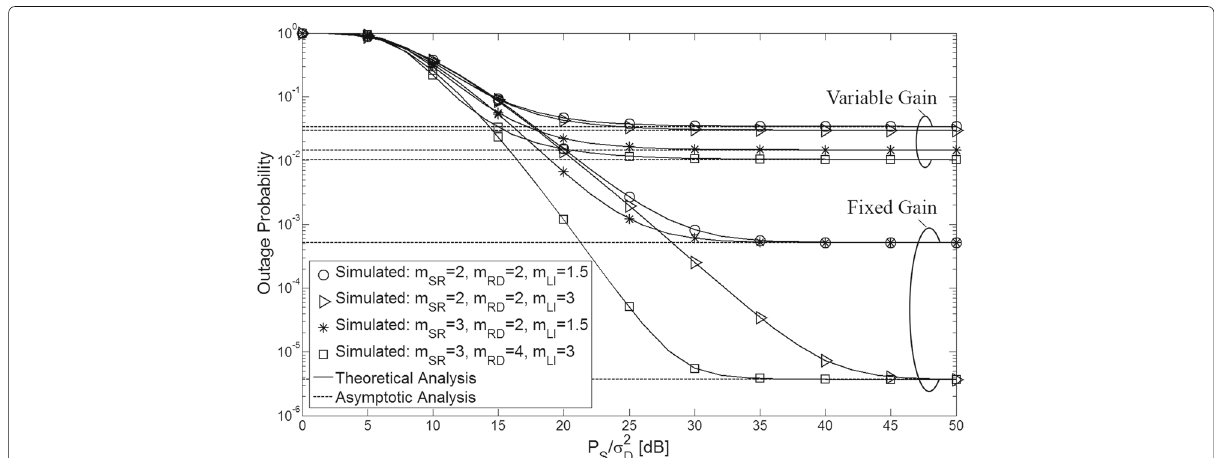
Fig. 4 Outage probability of the fixed-gain and variable-gain AF-FD systems for (cid:6) LI = 0.06, γ th = 2 and various m values